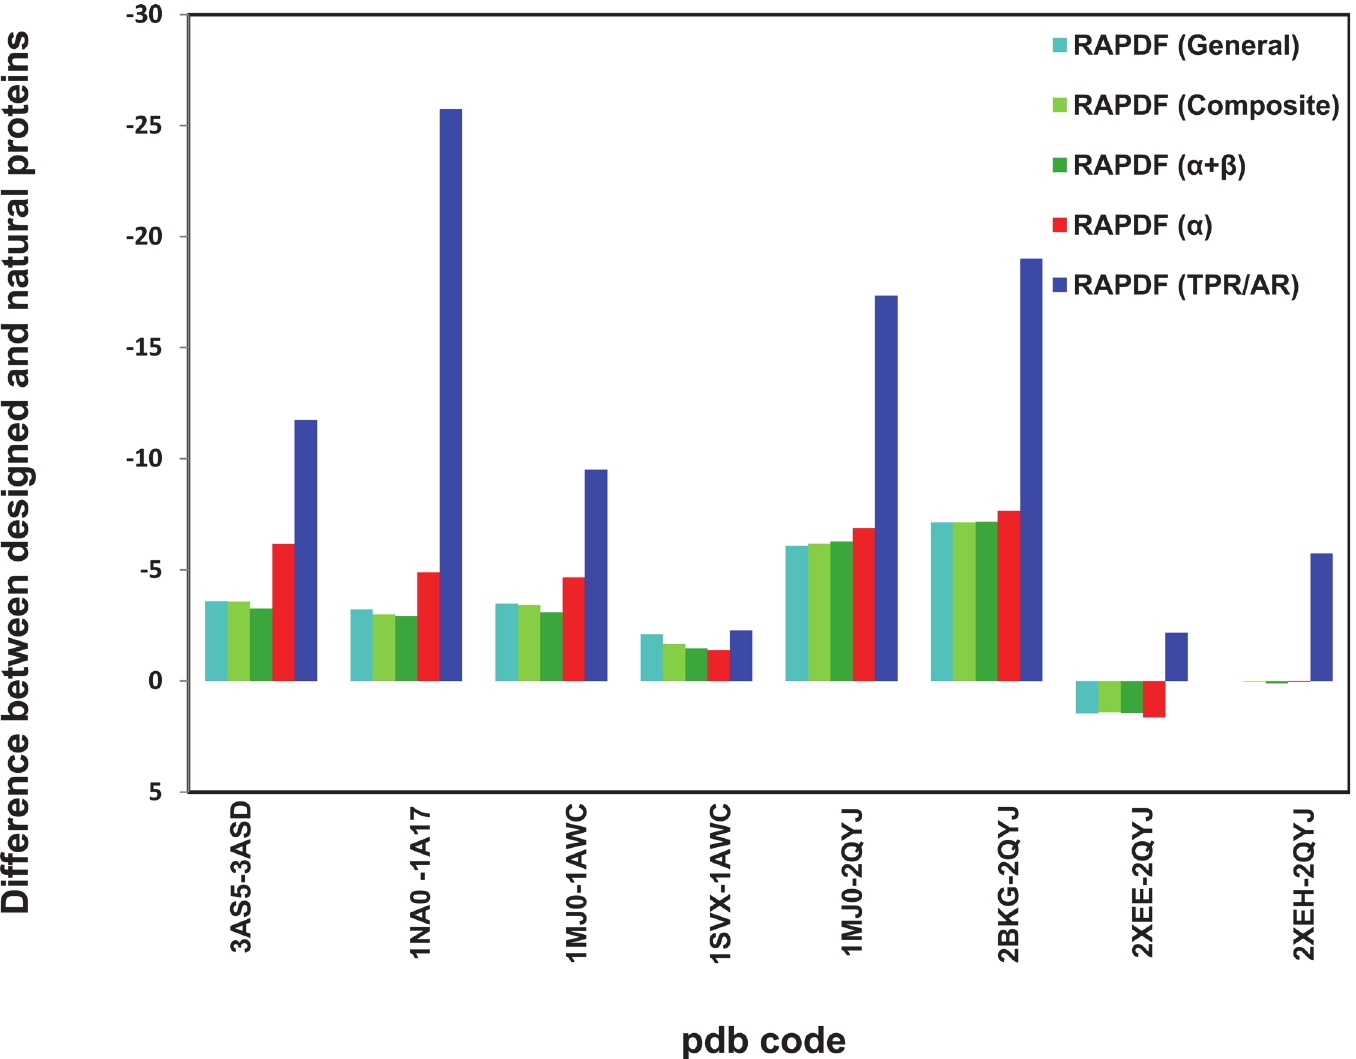
Fig 8. Predicted stability of designed repeat proteins using distance-dependant statistical potential based on TPR (light blue) or AR (blue) protein libraries.